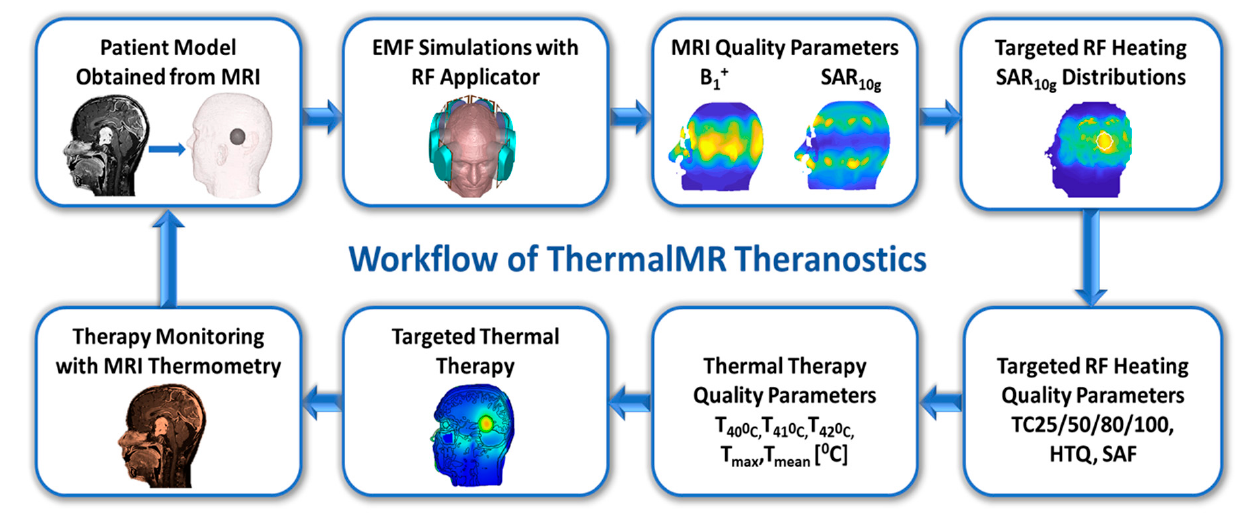
Figure 1. Scheme of thermal MR treatment planning (TMTP). B 1+ = transmission field used for MRI; TC = tumor coverage; T = temperature; SAR = specific absorption rate; SAF = SAR amplification factor; HTQ = hotspots-to-target